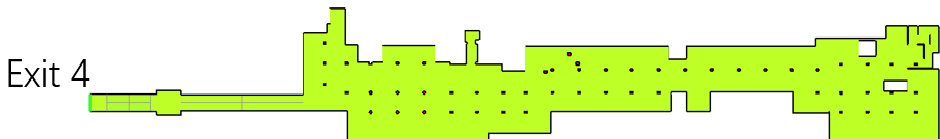
Figure 3. Property layer model diagram.